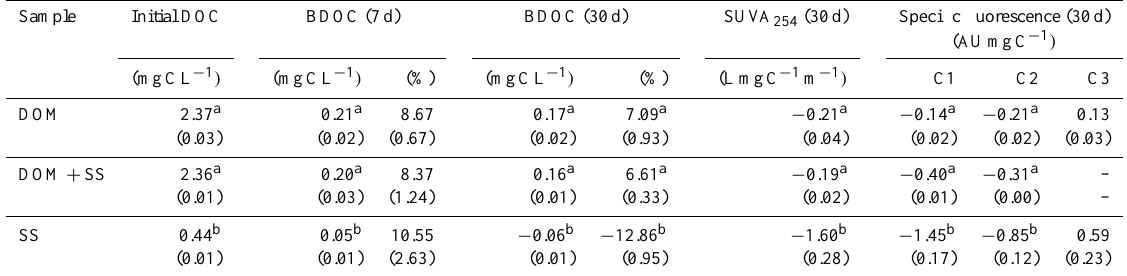
Table 2. Changes in DOC concentrations (mgCL − 1 ) over 7 and 30 days and SUVA 254 (LmgC − 1 m − 1 ) and specific fluorescence (AUmgC − 1 ) over 30 days of